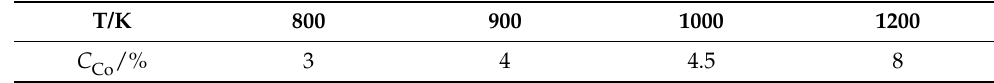
Figure 1. Ti – Co binary alloy phase diagram data from [22,23]. Figure 1. Ti–Co binary alloy phase diagram data from [22,23]. Table 3. Solubility of Co in Ti at different Table 3. Solubility of Co in Ti at different temperatures.